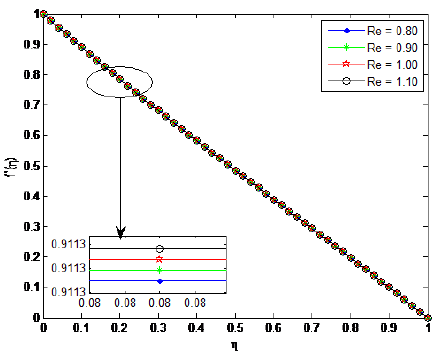
Figure 18. Influence of Reynold’s number on dimensionless velocity